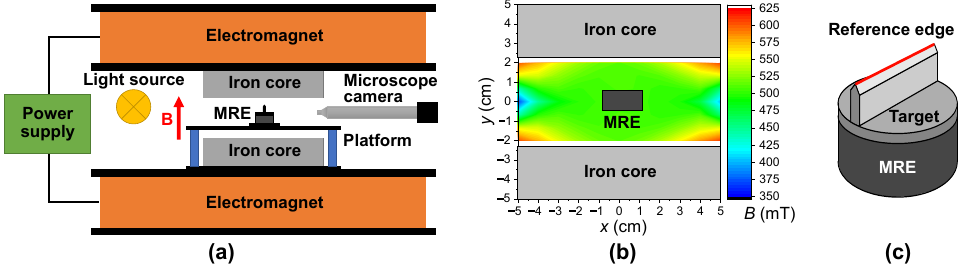
Figure 1. Schematics of the measurement system ( a ). The distribution of the magnetic flux density between the poles in the volume of the sample (dimensions indicated are in scale) is uniform within 1% ( b ). The edge of the target (shown by the red line) placed on top of the sample serves as a reference line for the detection of the deformation ( c